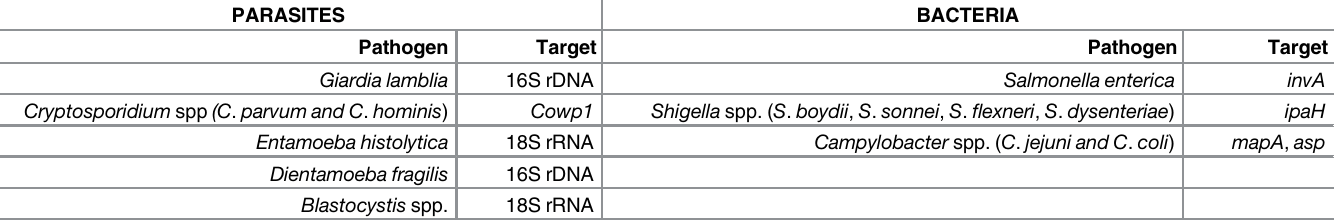
Table 1. Targets detected by the NanoCHIP 1 GIP test.